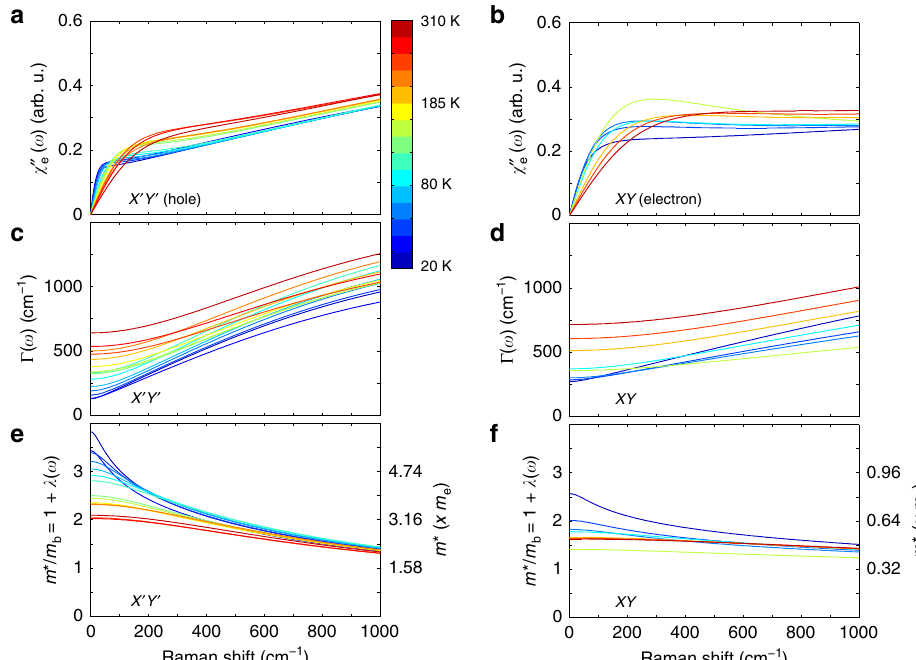
Fig. 4 Electronic Raman scattering and charge transport parameters from the MFL fi ts. Electronic Raman scattering response ( χ ″ e ( ω )) at several temperatures in a X 0 Y 0 and b XY . Dynamical scattering rates ( Γ ( ω , T )) in c X 0 Y 0 and d XY . The corresponding dynamical mass enhancement factors ( m */ m b ( ω , T )) in e , f , respectively. They were obtained from the marginal Fermi-liquid (MFL) fi ts, as shown in Fig.